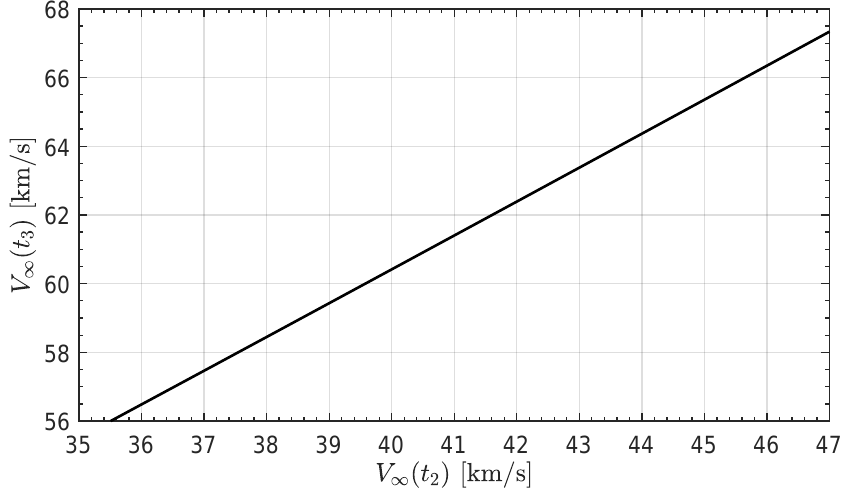
Figure 17. Hyperbolic excess velocity at the end of phase 3 as a function of that at the end of phase